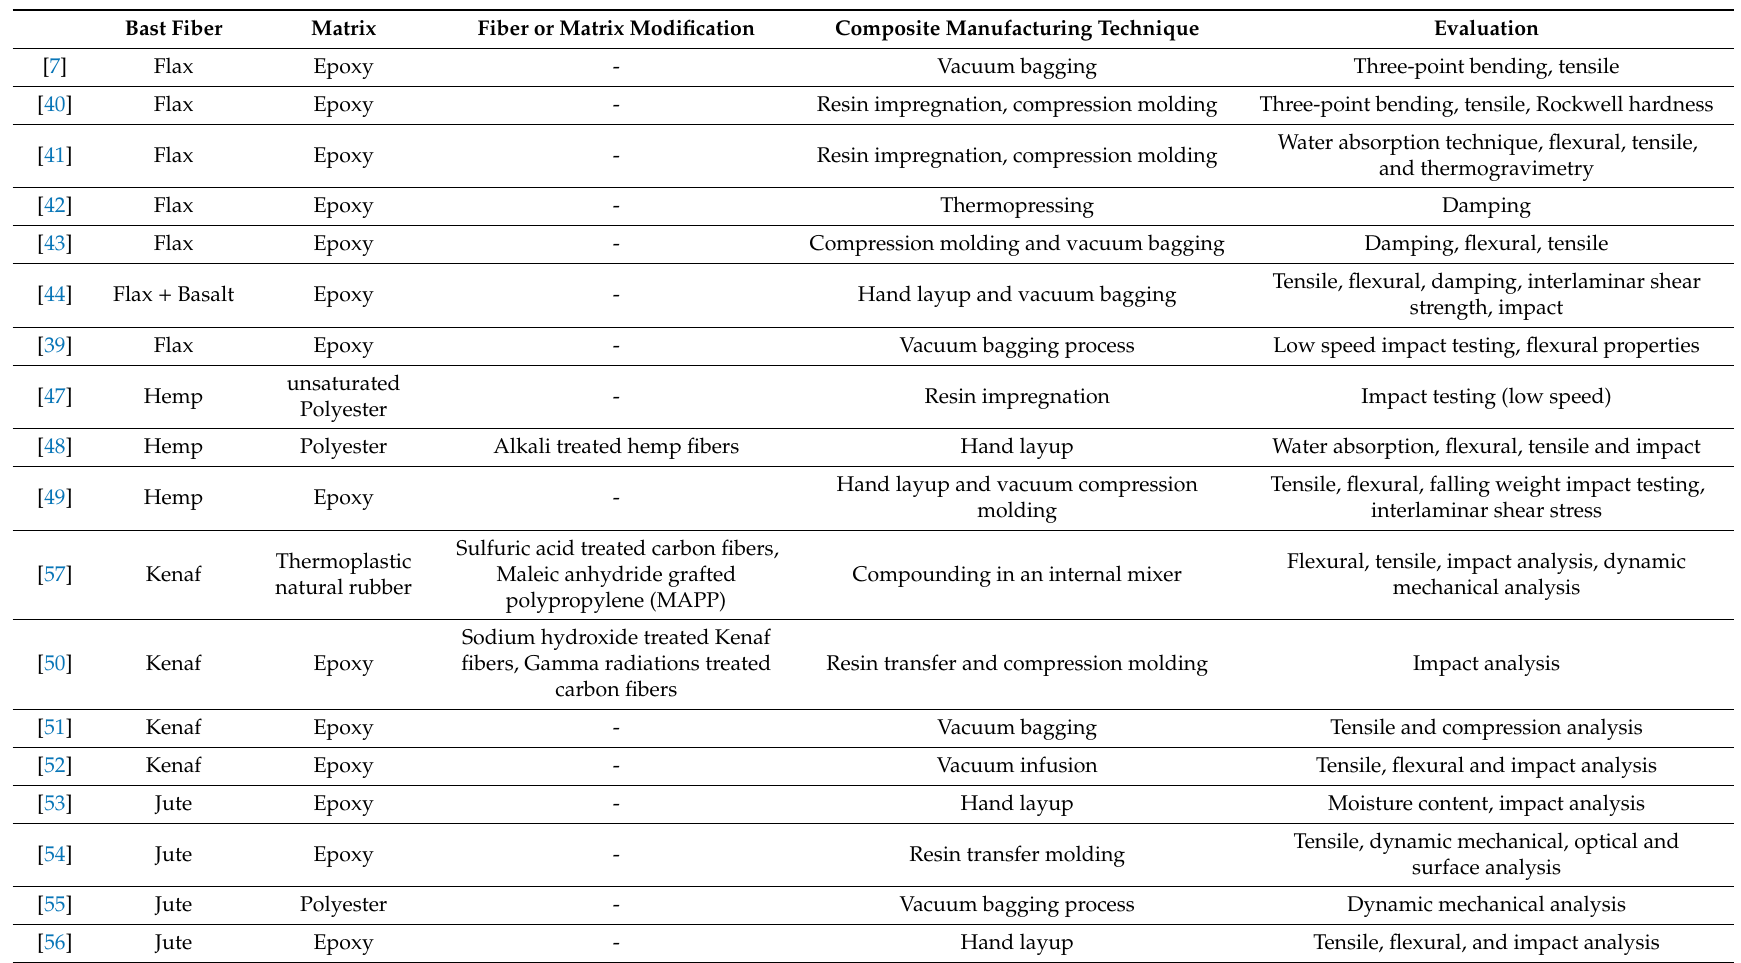
Table 3. Research contributions about hybrid bast / carbon fibers